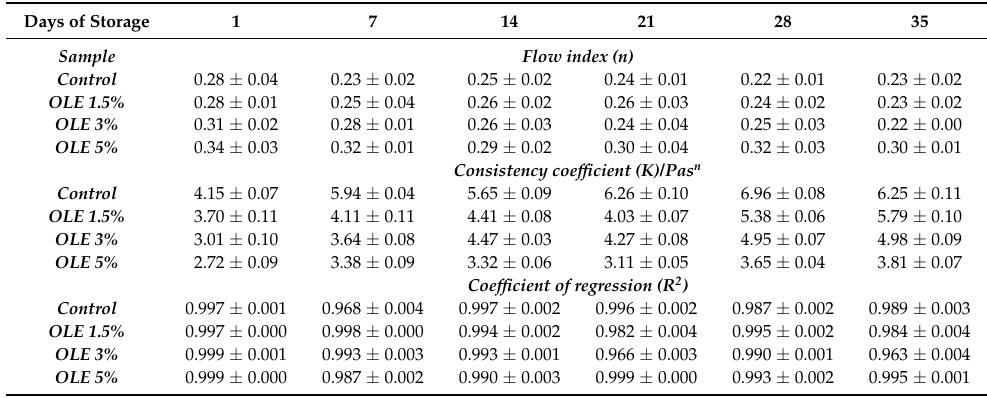
Table 3. Parameters of rheological behaviour (flow index ( n ); consistency coefficient K (Pas n ); co- efficient of regression ( R 2 )) according to Ostwald–de Waele model in the control sample and OLE-